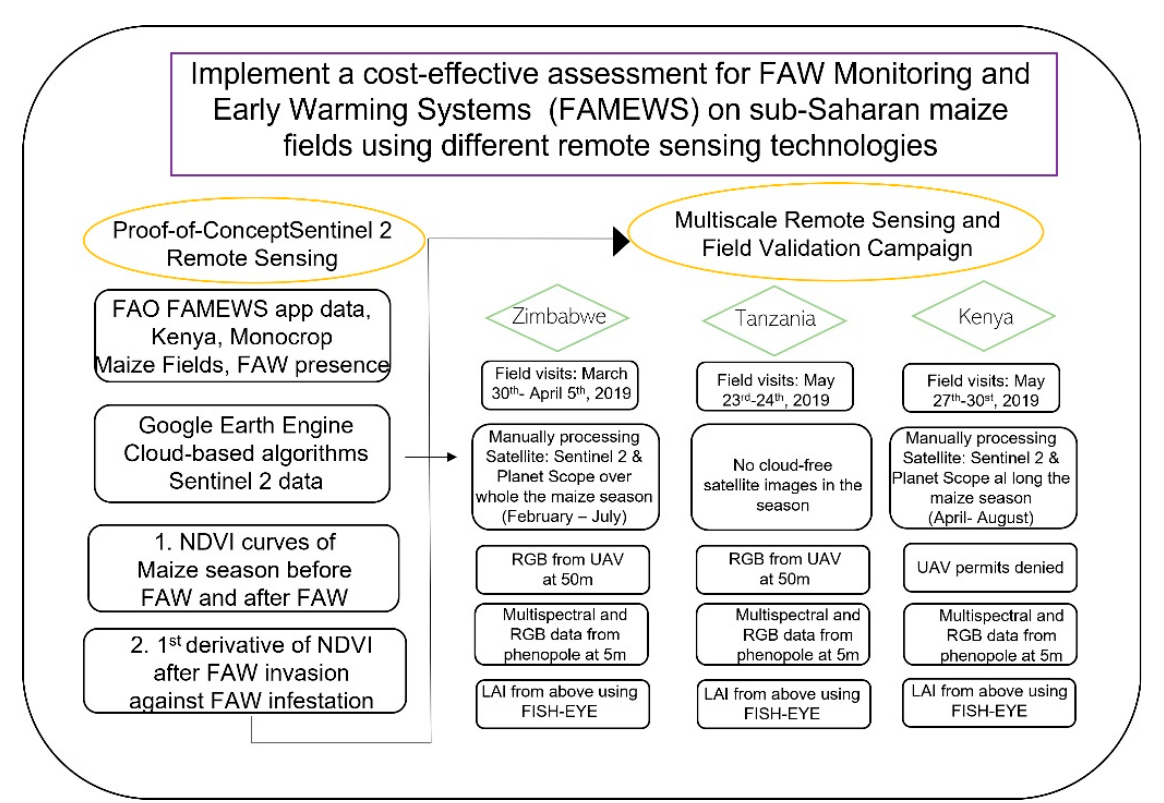
Figure 3. Workflow summary of the principal objectives and the two separate specific phases of the project with all the processes for each location and study phase.